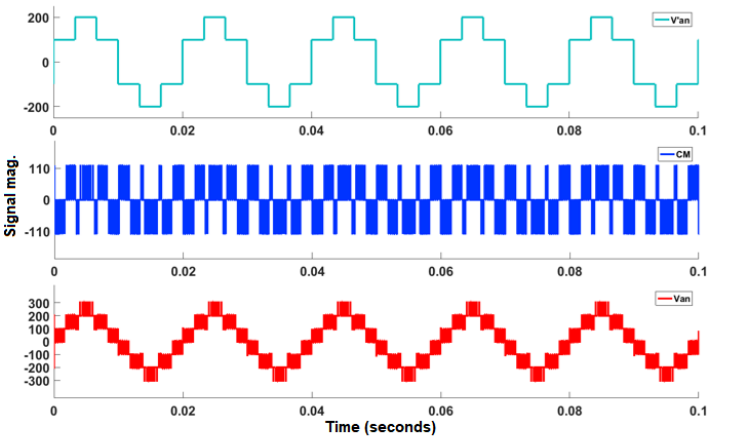
Figure 10. Single-leg phase-voltage of AHMMC (V an